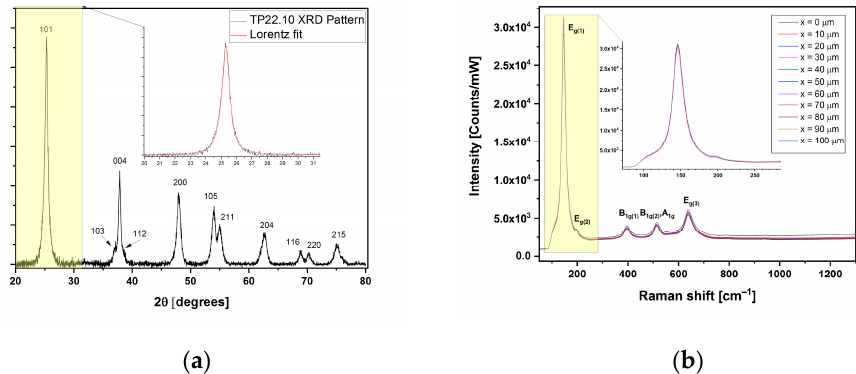
Figure 3. Characterizations of the TP22.10 sample ( a ) XRD pattern, with zoom in on 101 peak, and ( b ) Raman spectra collected at 514.5 nm at room temperature, at different positions of the TiO 2 NPs sample, with zoom in on mode E g(1) , at 147 cm − 1 .